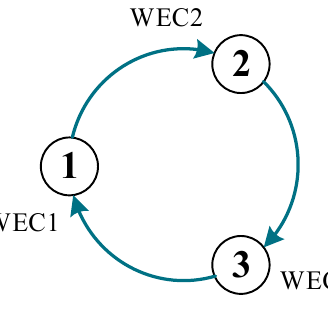
Figure 1. Graph of a cycle network.